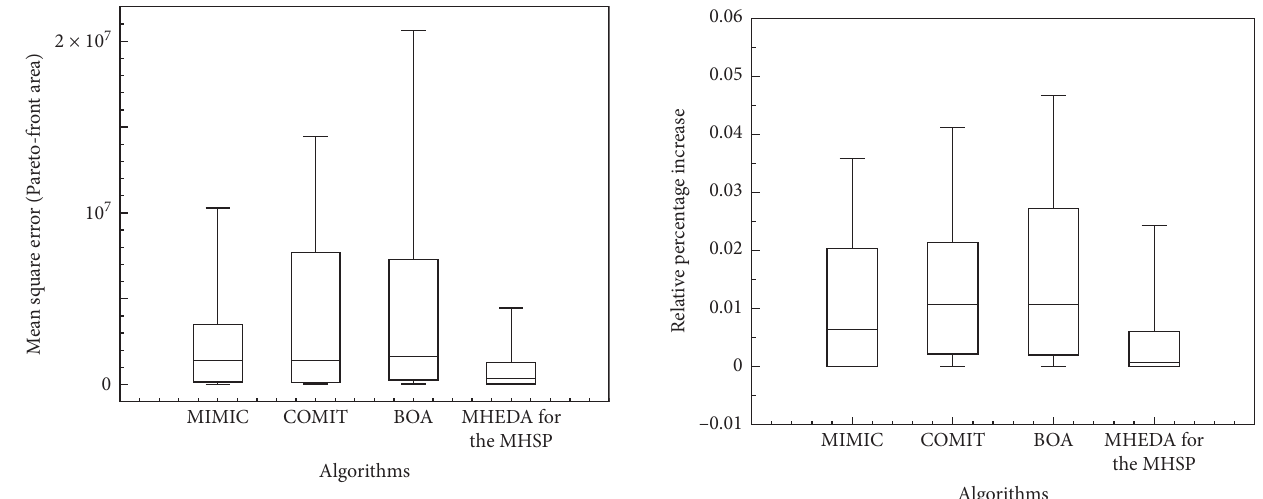
Figure 9: Comparison of results for the MHSP using the mean square error. Figure 10: Comparative results for the MHSP using the relative percentage increase.